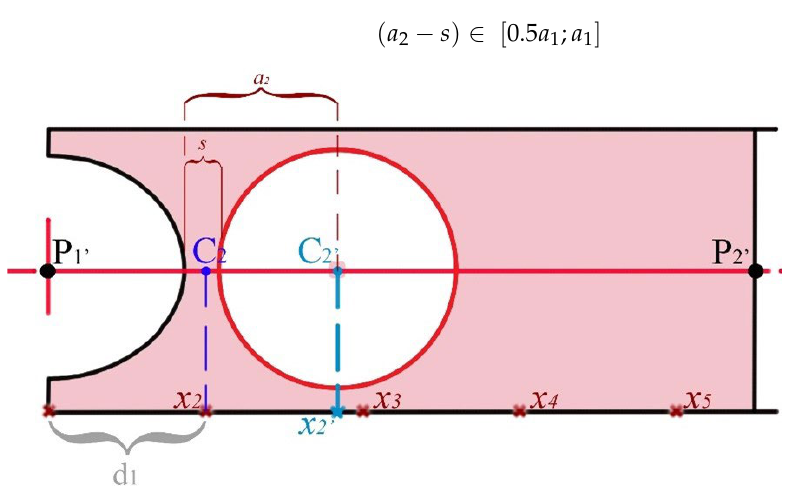
Figure 10. Void N.2.